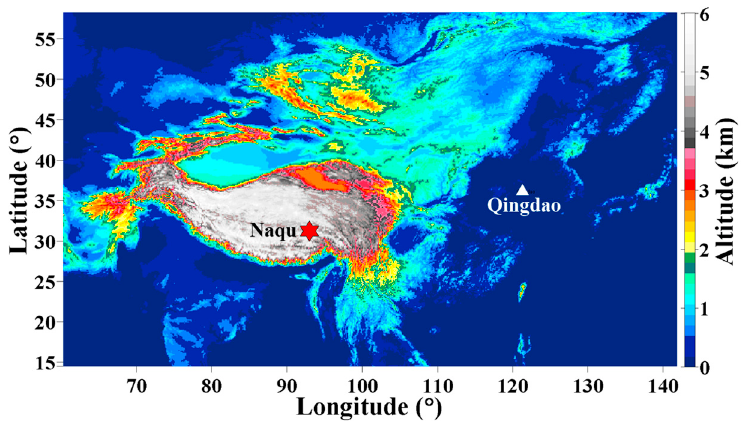
Figure 1. The altitude map with the red star denoting the LiDAR site during TIPEX III while the white triangle shows the location of Qingdao.